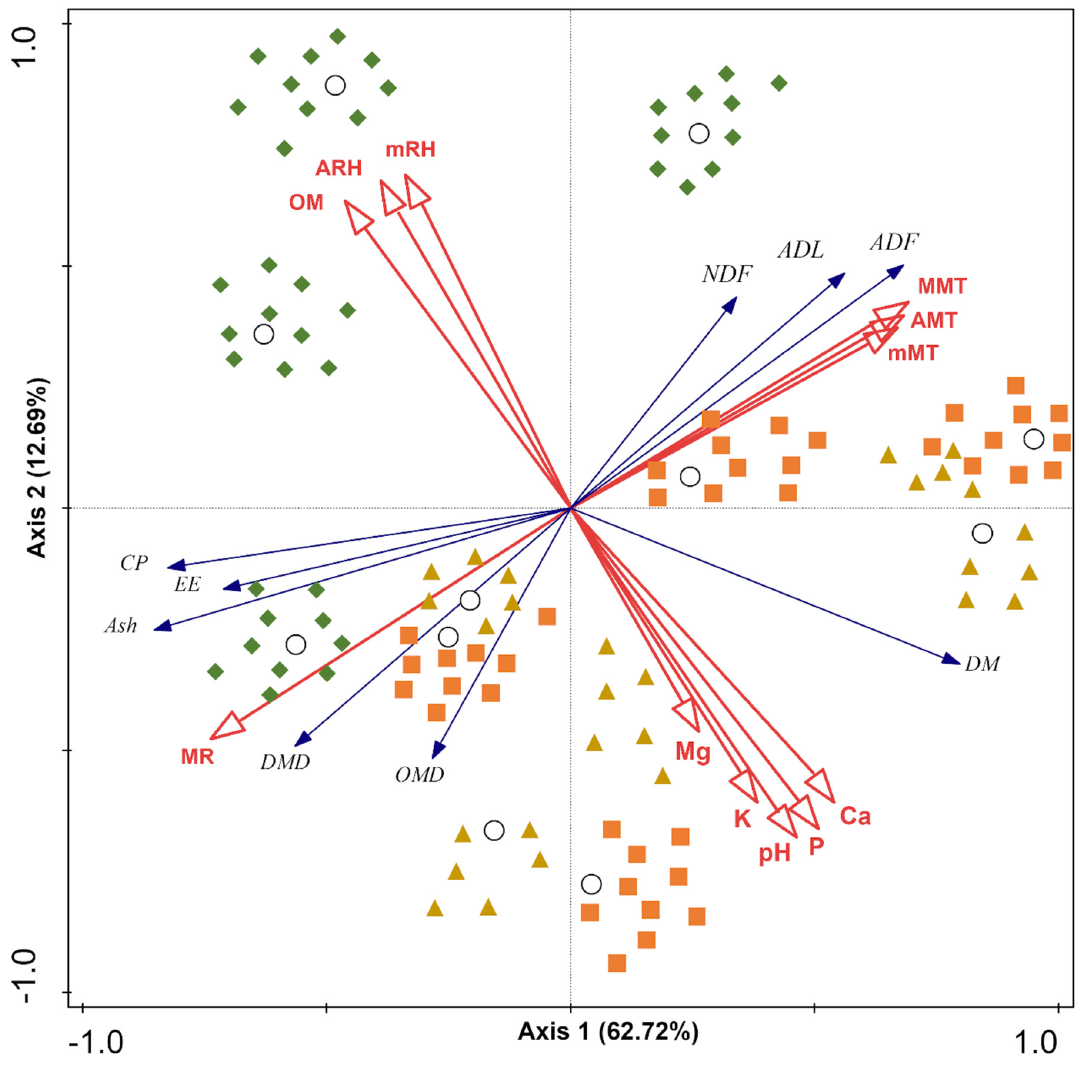
Figure 7. Redundancy analysis (RDA) of the relationships between environmental variables (red lines) and nutritive parameters (blue lines) from pastures A (yellow triangle) B (orange square) and C (green diamond) using Canoco 5.0 DM—dry matter, CP—crude protein, NDF—neutral detergent